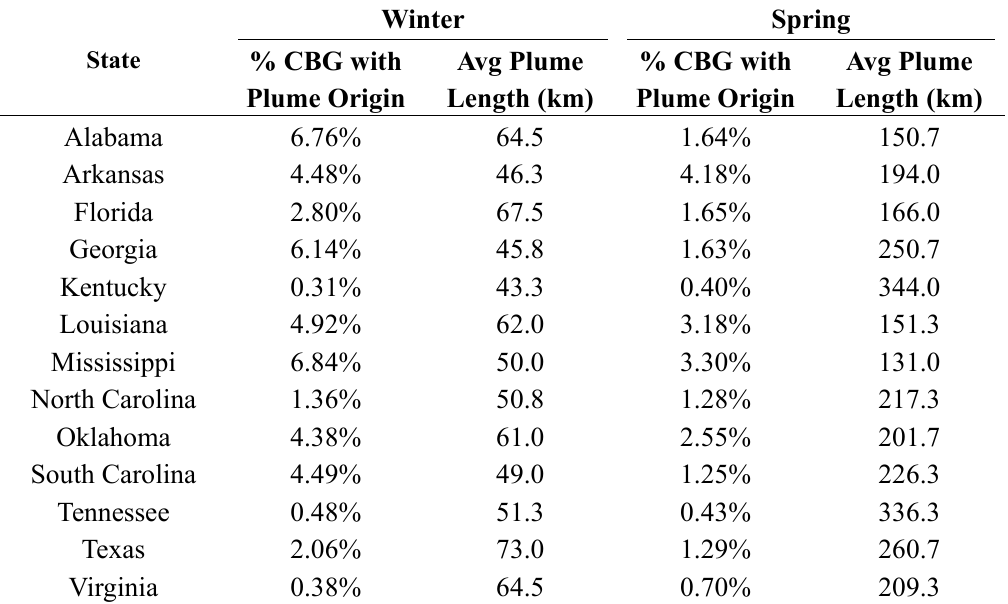
Table 1. Comparison of percentage of census block groups in each state where a smoke plume originates (by season) and the average plume length for each state by